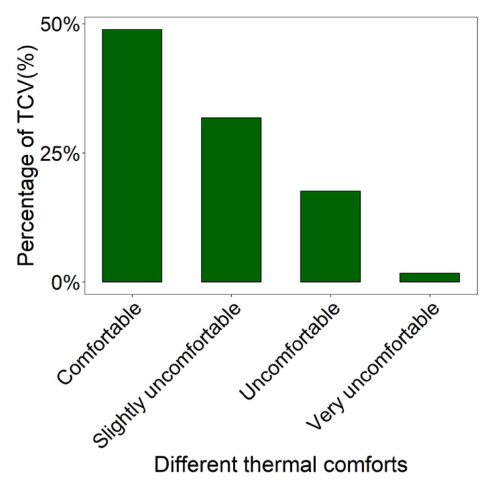
Figure 4. Thermal comfort vote.